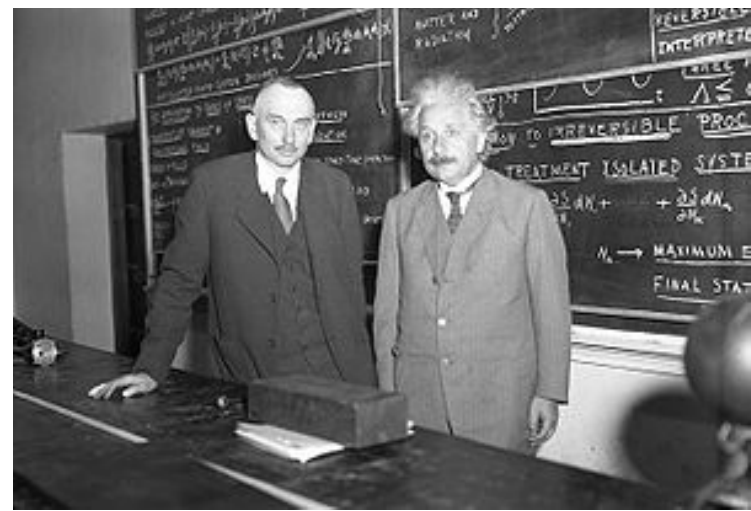
Figure 3. Richard Tolman with Einstein at California Institute of Technology in 1932. Taken from [30].